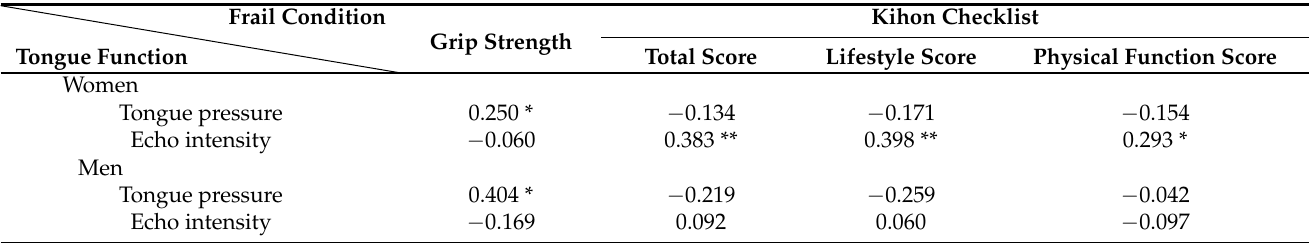
Table 3. Spearman’s correlation coefficients (Spearman’s rho) between assessments of tongue function and